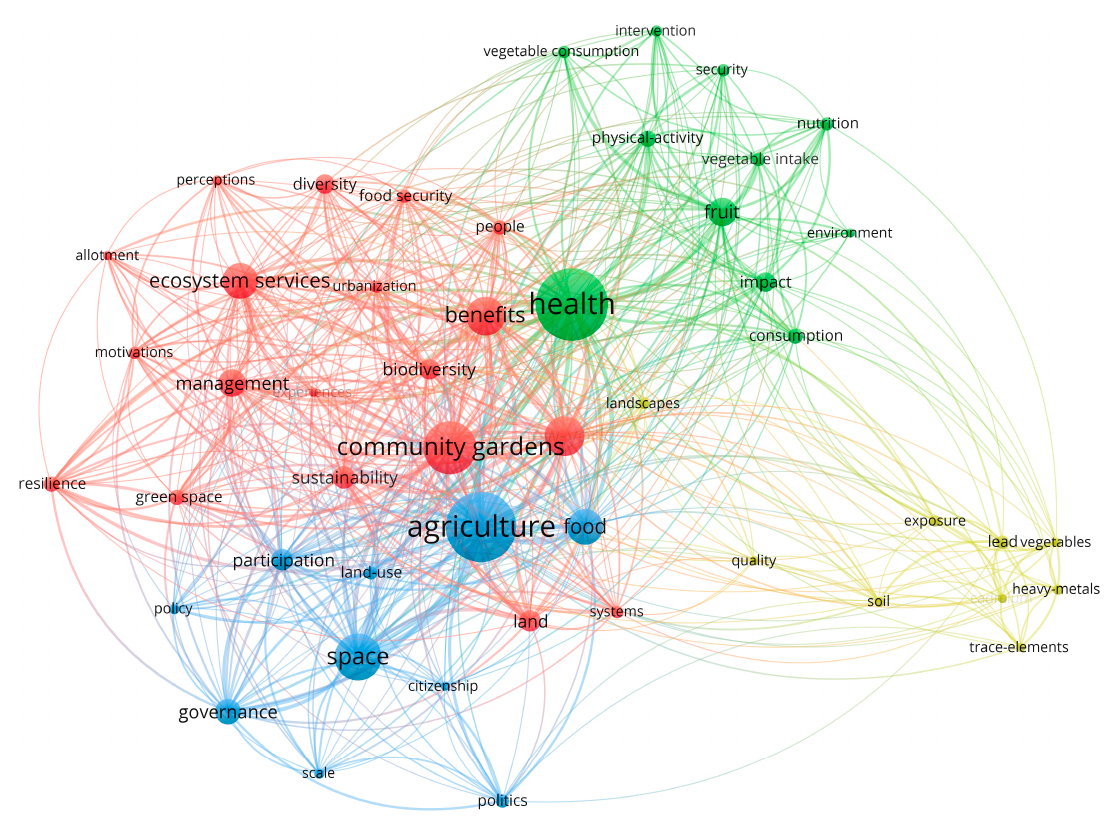
Figure 9. Top 50 keywords plus time-zone visualization of community gardens publications. The time-zone view consists of an array of vertical strips as time zones, which emphasizes the temporal relationships. The horizontal movement of an item is restricted to its own time zone, but its vertical movement is completely determined by its connections to items in other time zones.